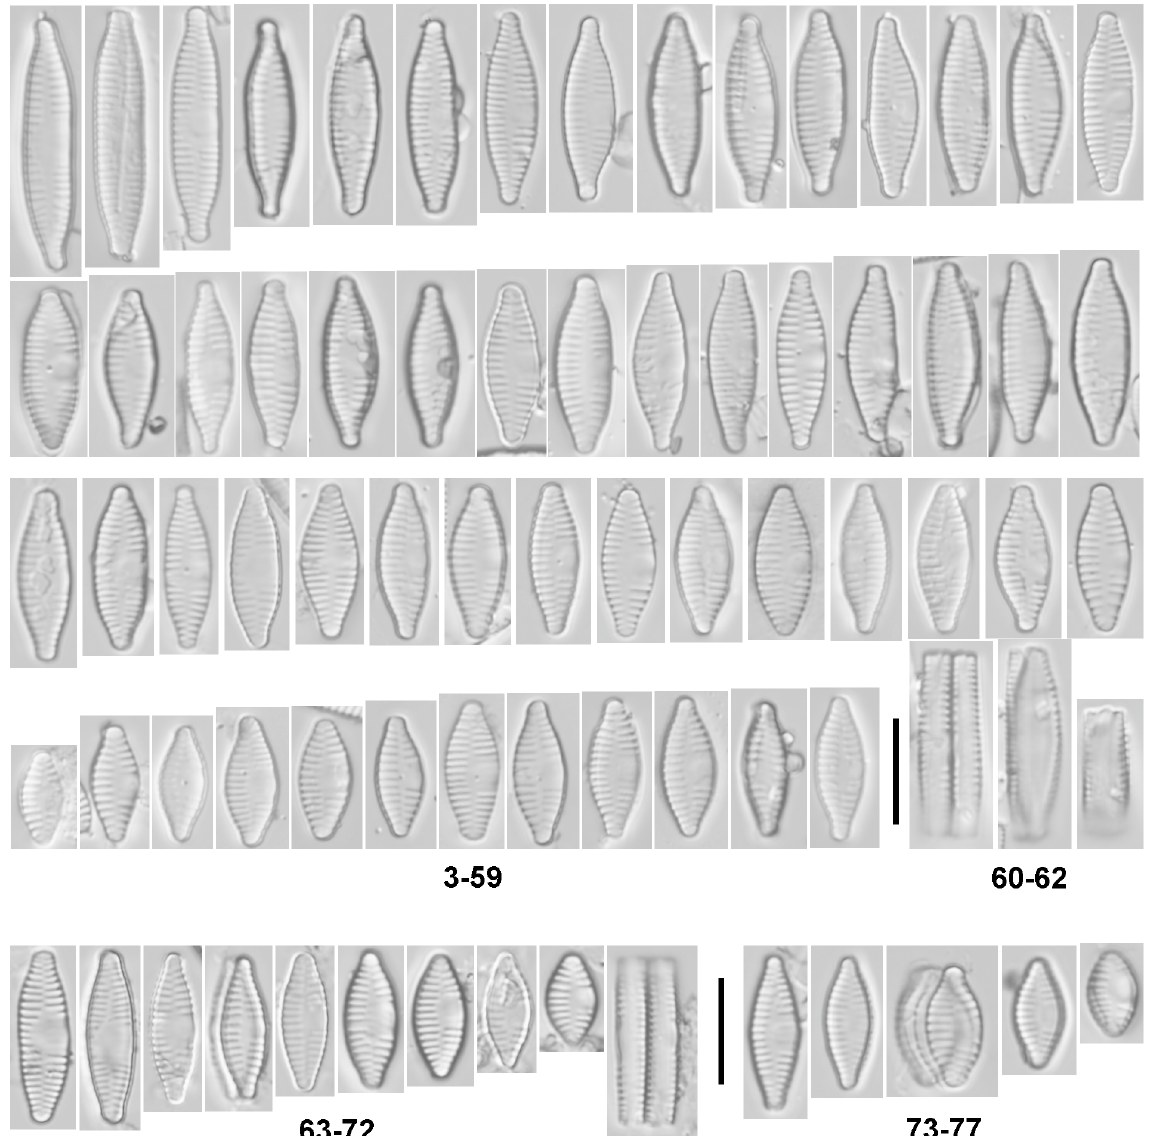
Figs 3–77. Light microscope images of Fragilaria rinoi Almeida & C.Delgado sp. nov. 3–62 . Mogofores (Cértima river, Vouga river basin, 21 Mar. 2012) type material (BM 101 794; Fig. 9 is from the holotype). 63–72 . Estarreja (Antuã river, Vouga river basin, 22 Mar. 2012). 73–77 . Foz do Ceira (river Ceira, Mondego river basin, 20 Mar. 2012). Scale bar = 10